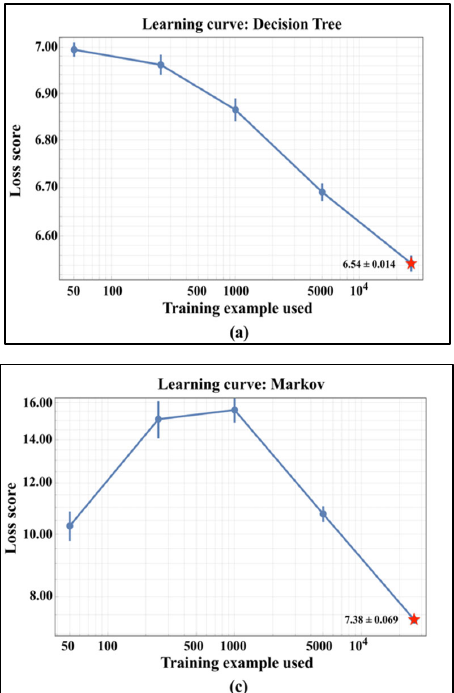
Fig. 2. THM information has been converted to Unicode for communication and processing with computers. The relevant English information was not converted to Unicode